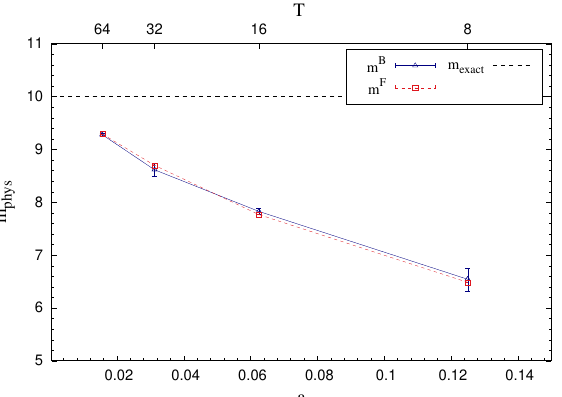
Figure 1 . Bosonic and fermionic mass gaps for SUSY harmonic oscillator with physical parameters m phys = 10 and g phys = 0 versus lattice spacing ( a ) and lattice size ( T ).